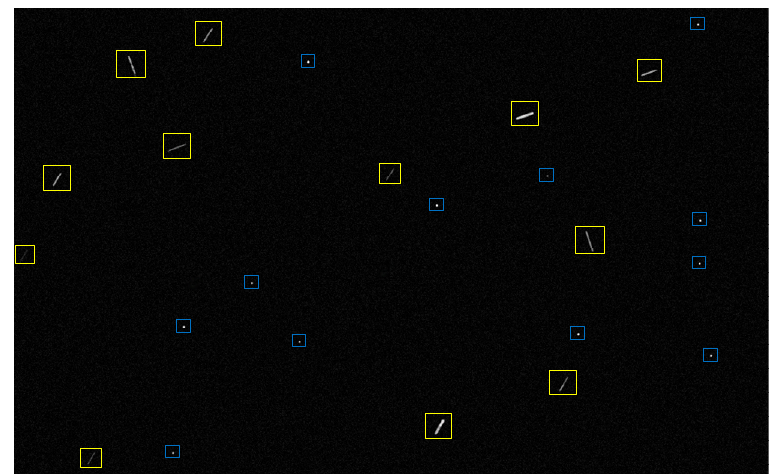
Figure 1. Star image containing fake star points.